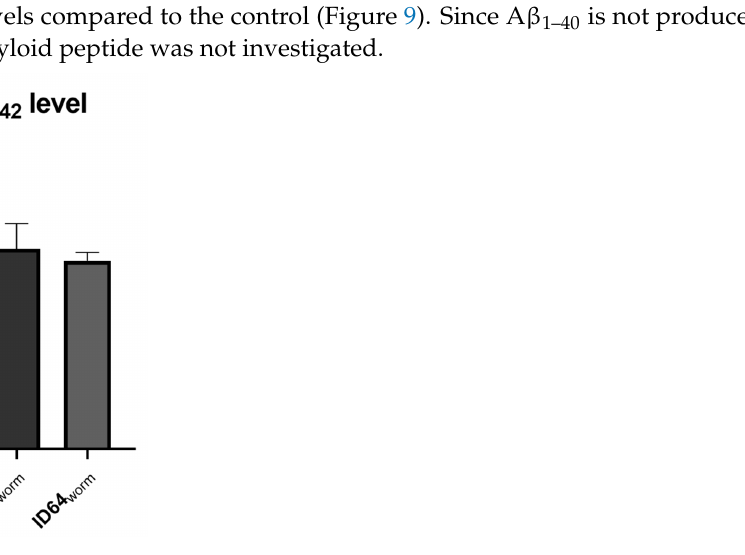
Figure 9. Effect of ID63 and ID64 in transgene nematodes GMC101 compared to the controls on the A β 1–42 level after 48 h incubation. Neither ID63 nor ID64 did not lead to a significant alteration of A β 1–42 . N = 8. A β 1–42 levels were adjusted to the protein content. N = 8. Mean ± SEM. Student’s t -test. ID63 worm = Fol 50 µM and MgOr 100 µM; ID64 worm Fol 50 µM, MgOr 100 µM and Vit B6 100 µM.